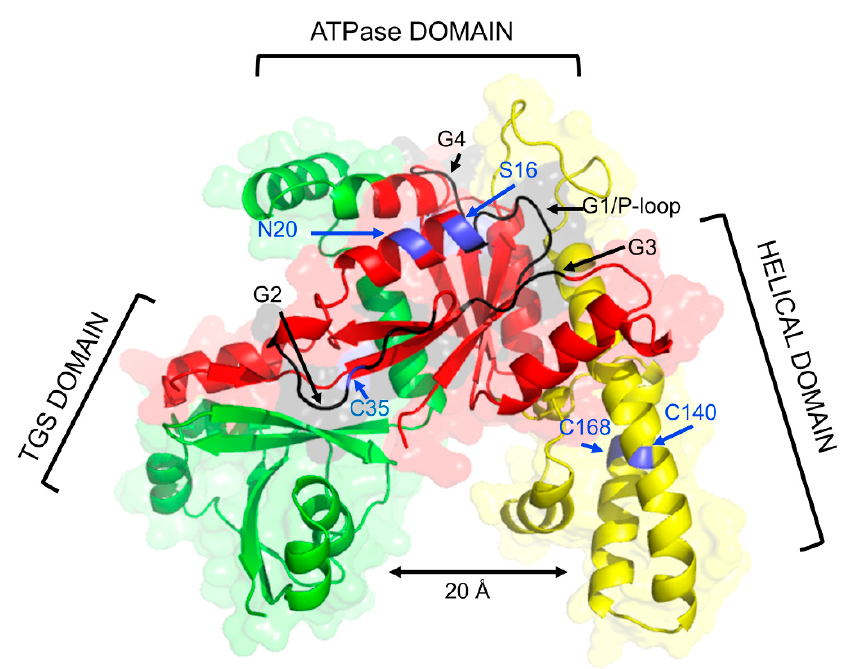
Figure 1. Structural model of E. coli YchF. The structure was retrieved from the Alphafold Protein Structure Databank (https://alphafold.ebi.ac.uk/, accessed on 27 November 2021). The ATPase domain is shown in red, the coiled-coil or helical domain in yellow and the TGS-domain in green. Indicated are the four G-motifs (G1–G4), which define and specify nucleotide binding, residue S16, which is phosphorylated, residue N20, which has been mainly used for in vivo site directed crosslinking and residue C35 that is involved in YchF dimerization. The helical domain contains two additional Cys residues in close proximity (C140 & C168), which could act as a redox